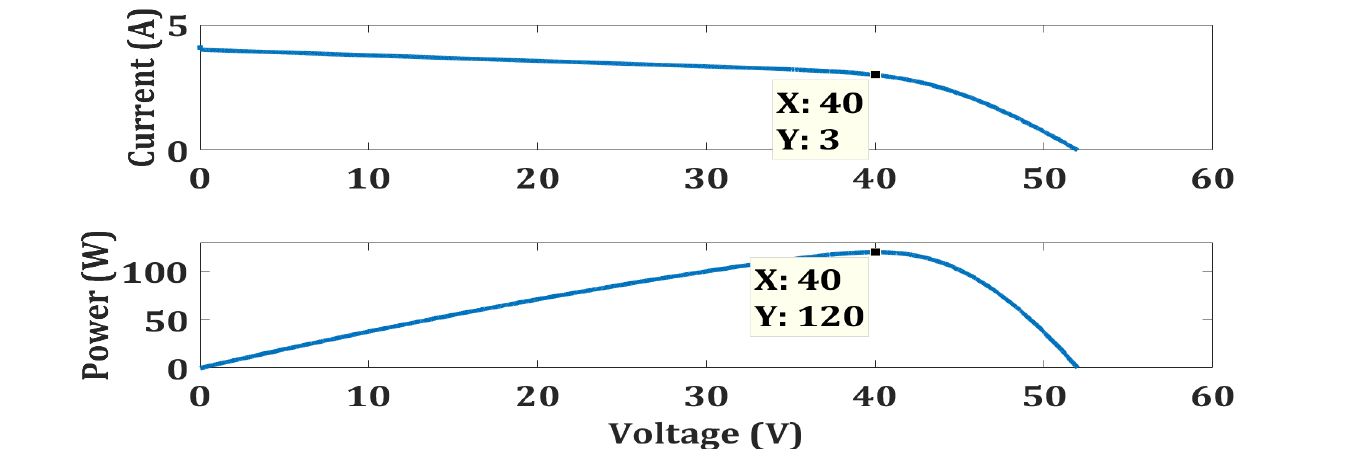
Fig. 6. I-V and P-V characteristic curves of a 4S PV array in zero shading